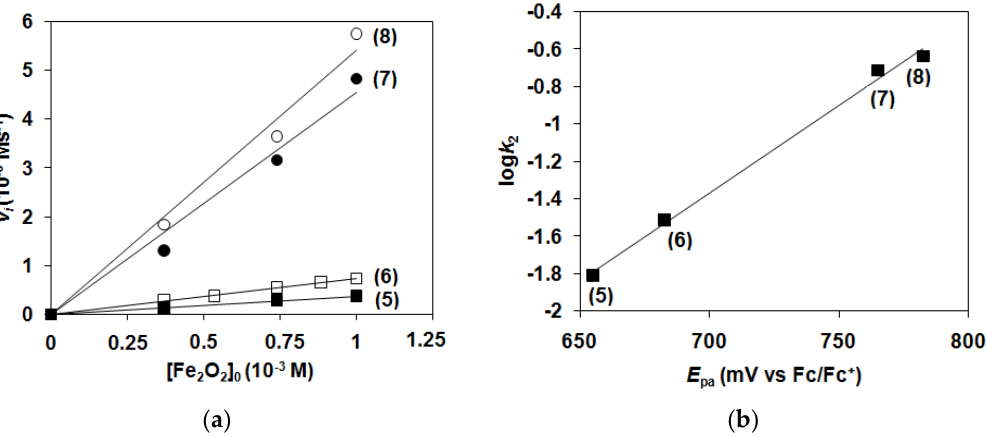
Figure 6. Peroxo-diiron complexes-mediated disproportionation of H 2 O 2 in CH 3 CN at 15 ◦ C. ( a ) Dependence of the reaction rate ( V i ) for H 2 O 2 oxidation on the diiron-peroxo complex 5 – 8 concentration. [H 2 O 2 ] 0 = 24 mM ( b ) Dependence of the decay rate of peroxo-diiron complexes ( 5 – 8 ) on the oxidation potential ( E pa ) of the [Fe II (L 1–4 )(solvent) 3 ](ClO 4 ) 2 ( 1 – 4 ) complexes.